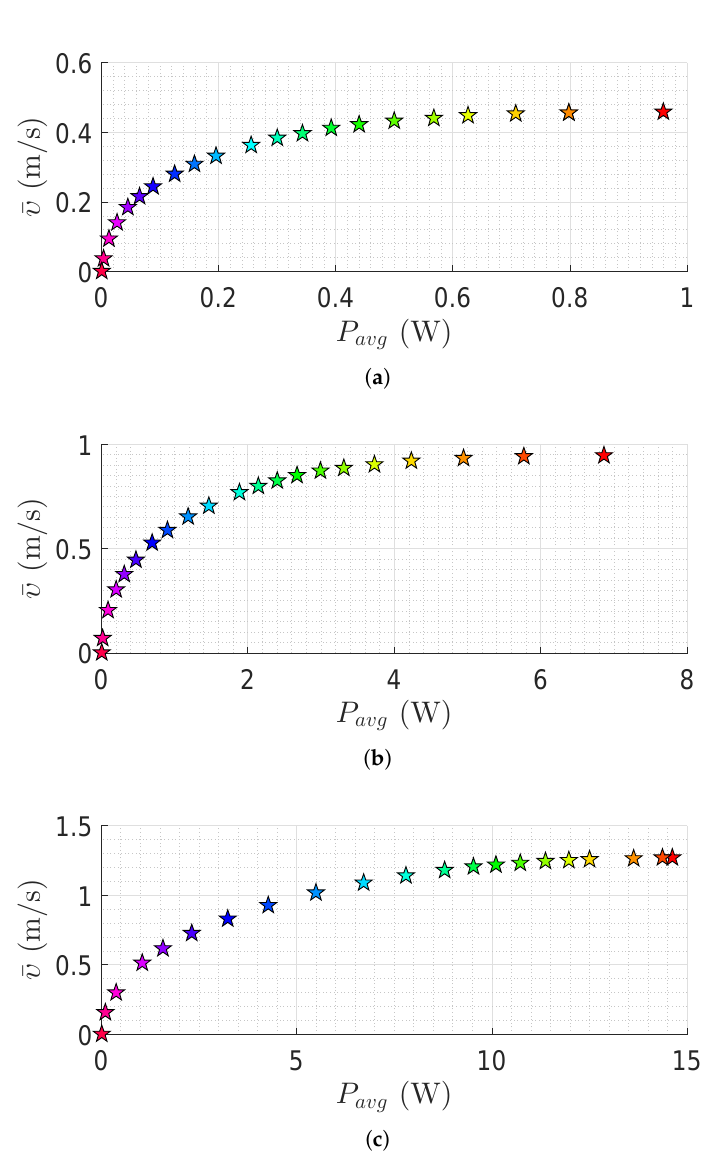
Figure 10. Pareto front for the land-based snake robot using the lateral undulation motion pattern: ( a ) Pareto front for robot with n = 5 links; ( b ) Pareto front for robot with n = 10 links; and ( c ) Pareto front for robot with n = 20 links. Colors illustrate different weights of the objective functions.